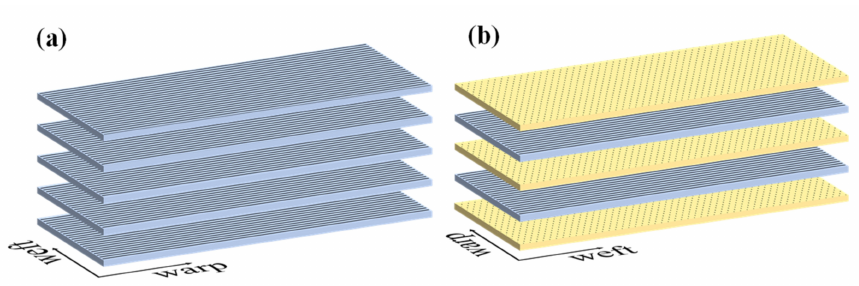
Figure 3. Fabric laying modes: ( a ) Unidirectional ply [0] n ; ( b ) Orthogonal layup [0/90] n .